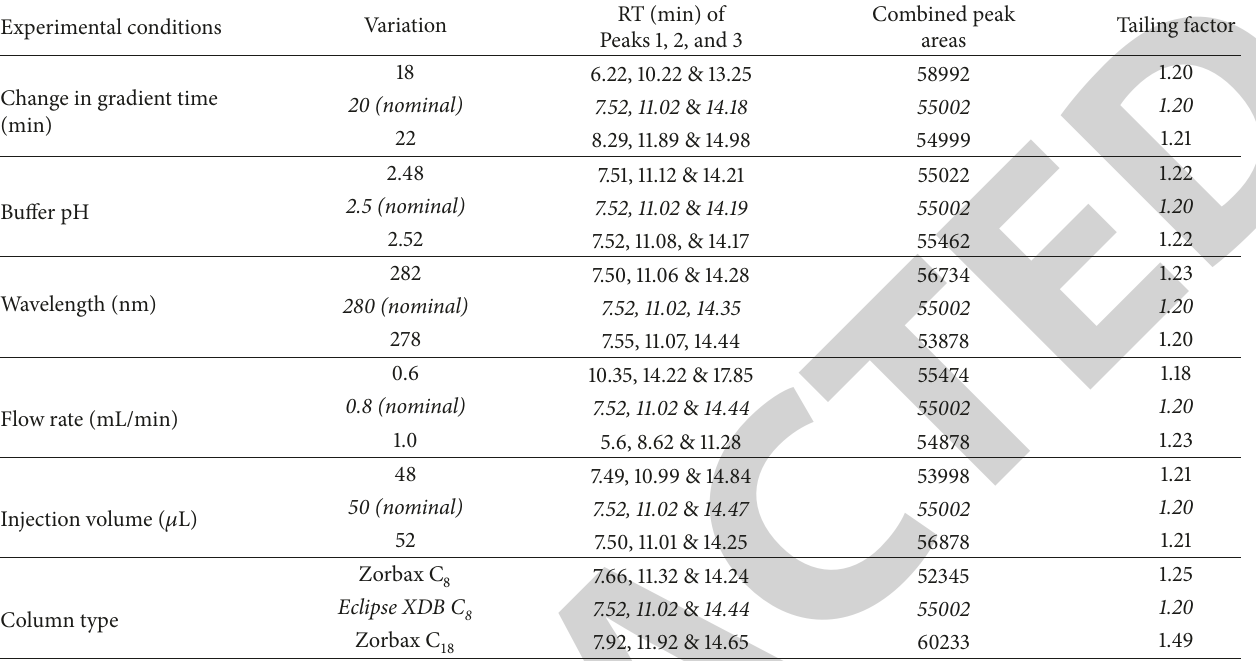
Table 4: Summary of robustness studies.